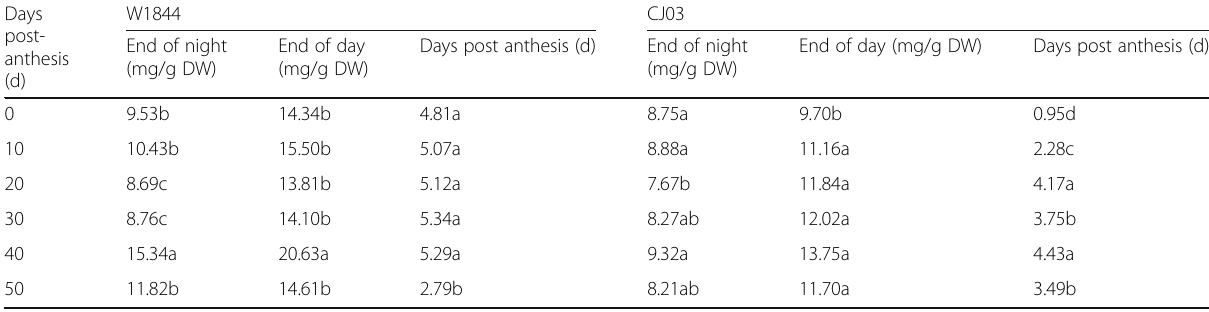
Different letters indicate statistically significant differences at the P =0.05